Question: Author a descriptive caption for the visualization shown.
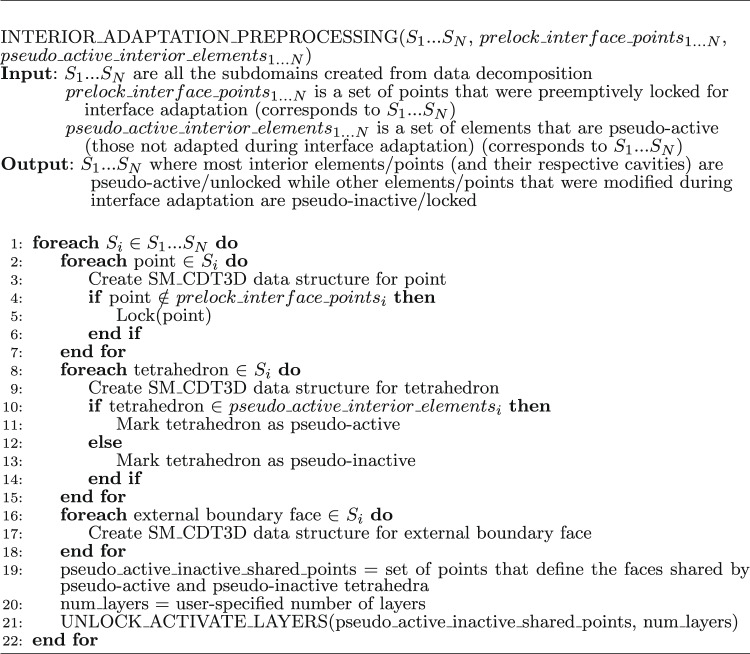
Answer: Interior Adaptation Preprocessing